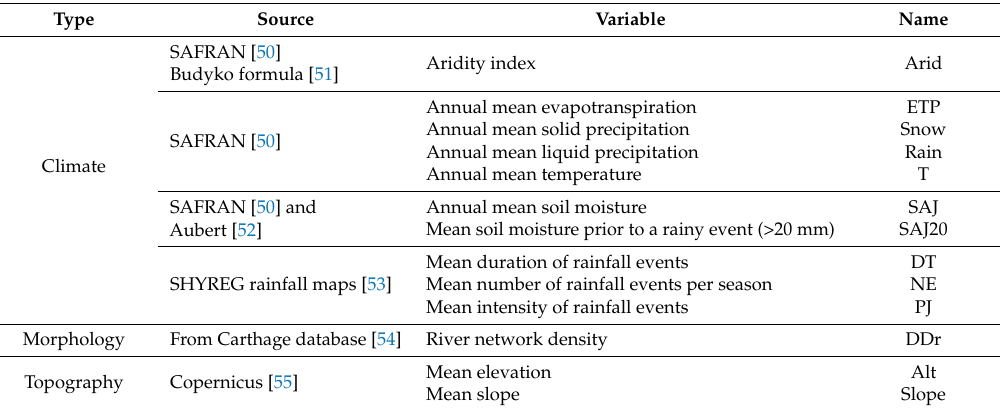
Table 2. Catchment descriptors.